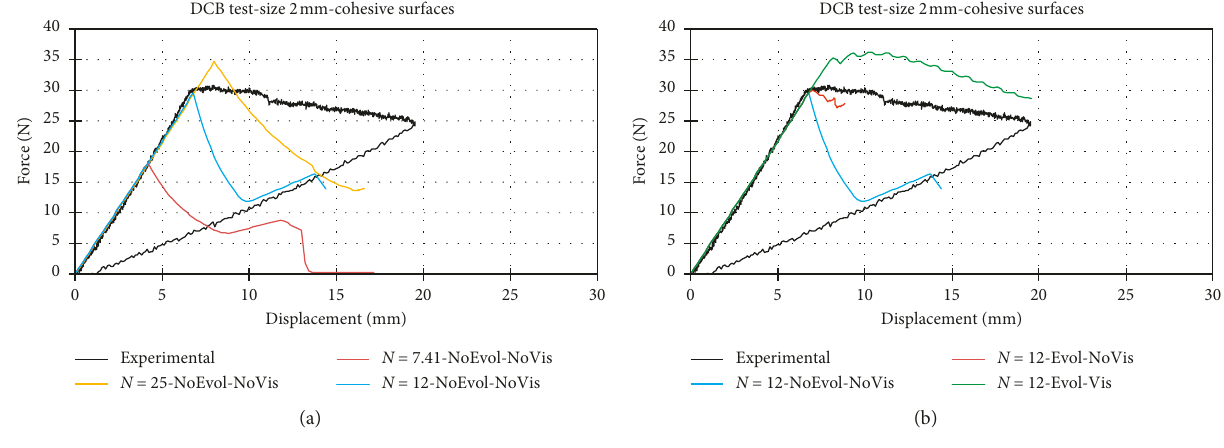
Figure 15: DCB test: cohesive surface approach (element size 2